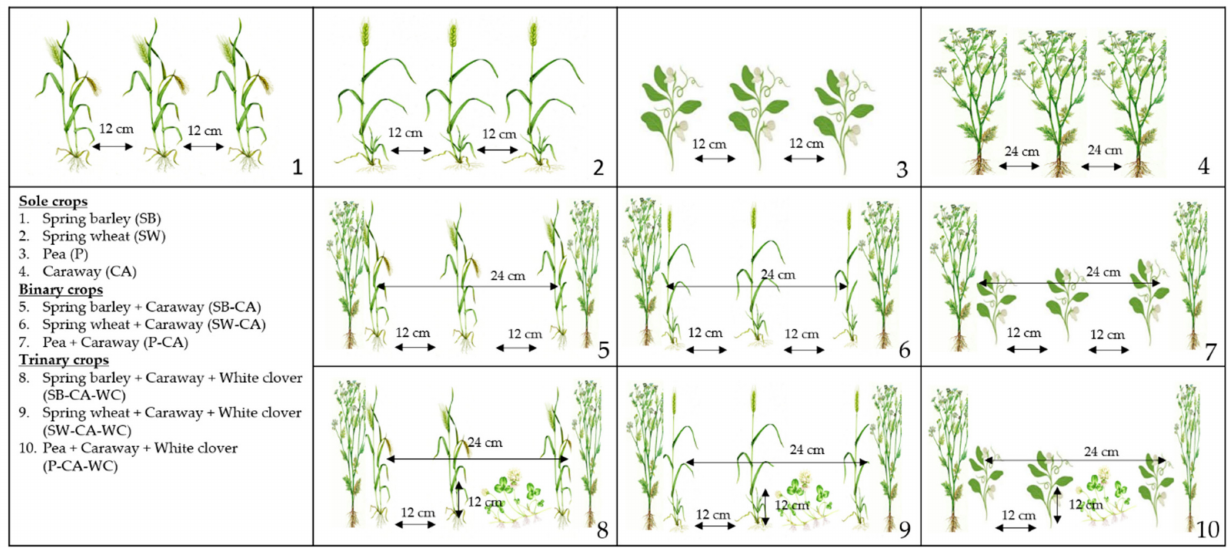
Figure 6. Experimental treatments: Four treatments were formed by sole crops, three treatments were combinations of caraway with the other crops as binary crops, and three treatments were trinary crops with white clover added to binary